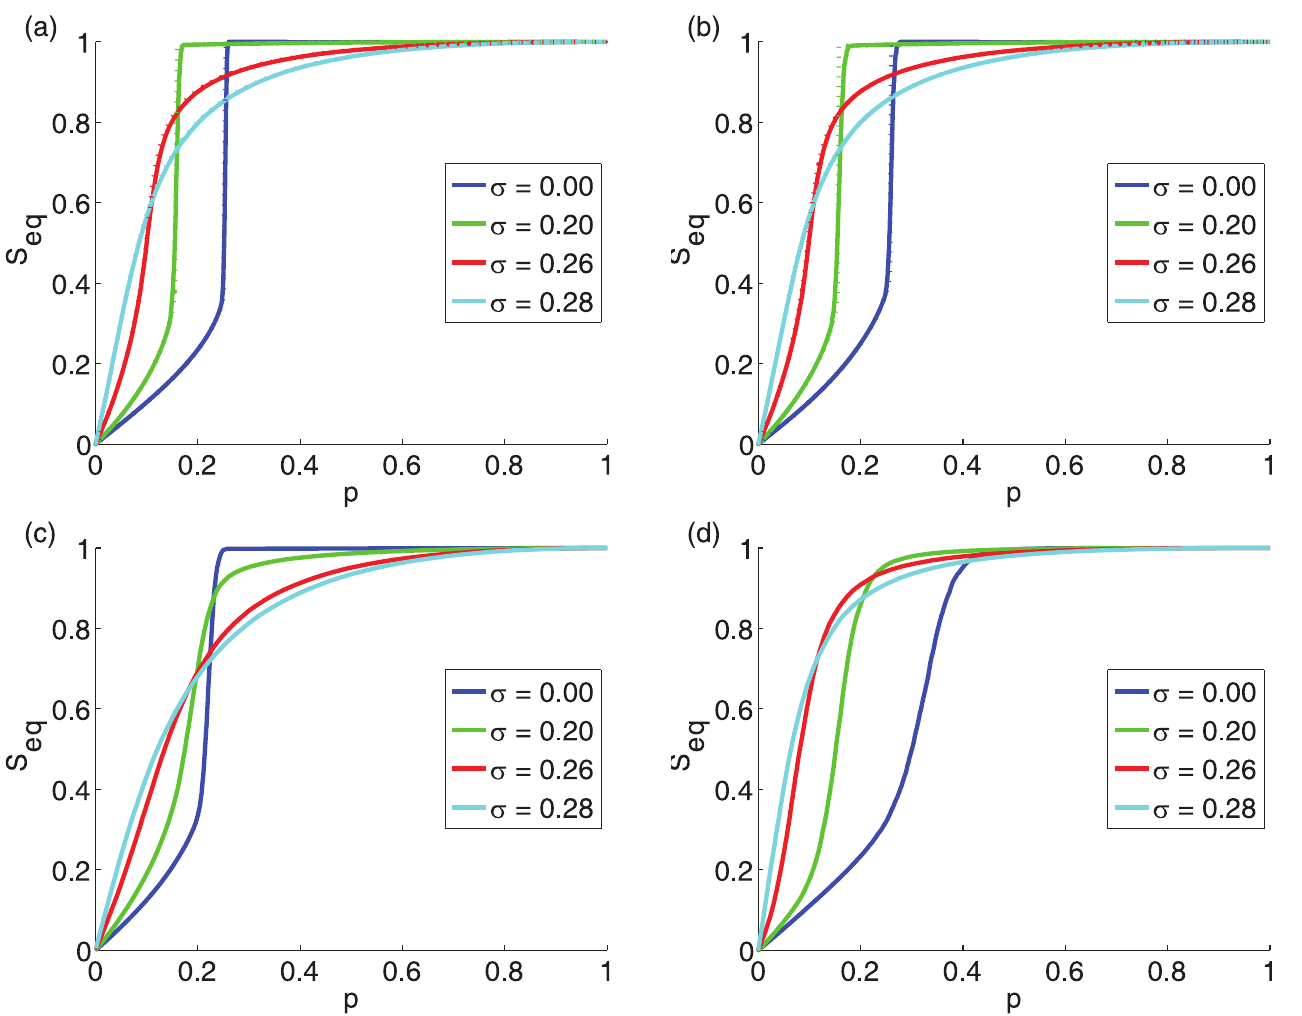
Fig 3. Behavior of the cascade size S eq at equilibrium vs. the initiator fraction p . The networks are the same as in Fig 1: (a) ER graphs with z = 10 and N = 10 4 ; (b) SF networks with z = 10, γ = 3, and N = 10 4 ; (c) high-school network with z = 5.96 and N = 921; (d) facebook network with z = 43 and N = 4039. The mean threshold is ϕ 0 = 0.50. (a) and (b) also shows the analytic estimates (dotted lines) based on the tree-like approximation (see Materials and Methods)